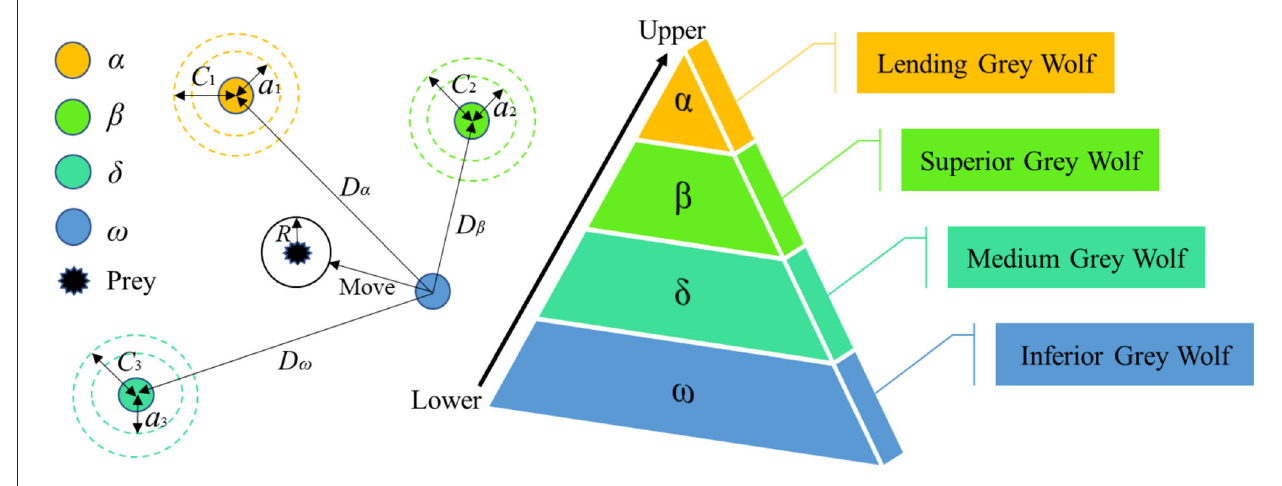
FIGURE1 Schematic diagram of